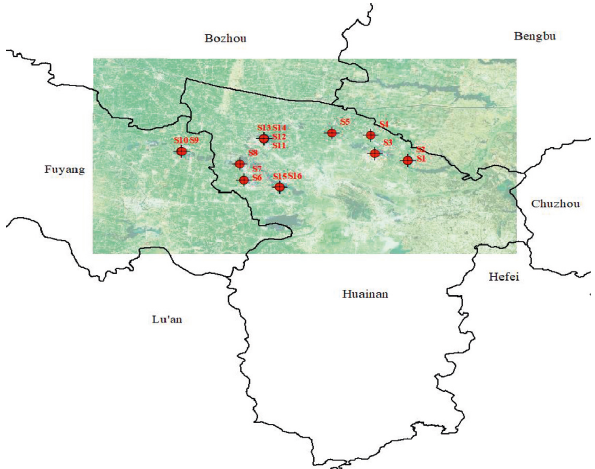
Figure 1: Sampling points located in the coal mining subsidence water area of Huainan,